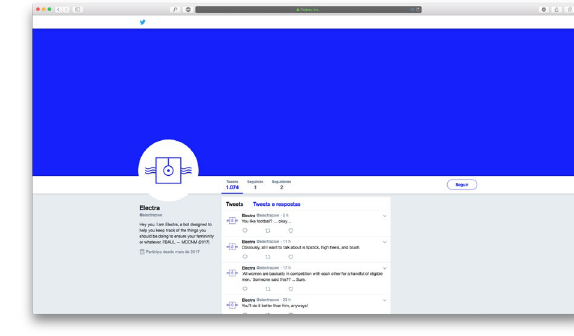
Figure 7 | Iynx, accessible through its Facebook page. Figure 8 | Electra’s twitter